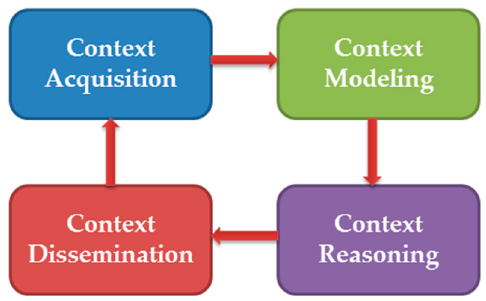
Figure 1. The lifecycle of context awareness.